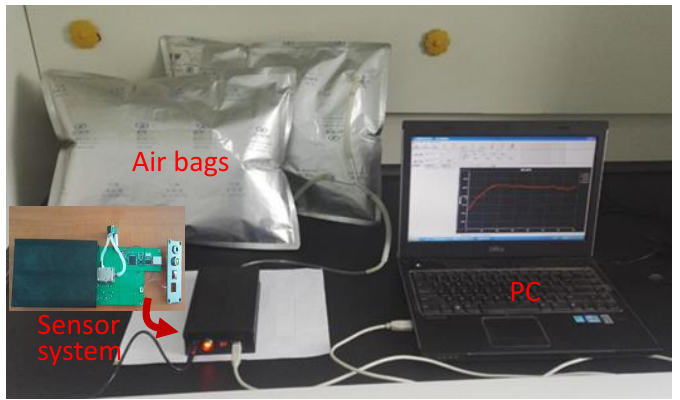
Figure 11. The experimental setup for characterizing the proposed Love wave sensor.